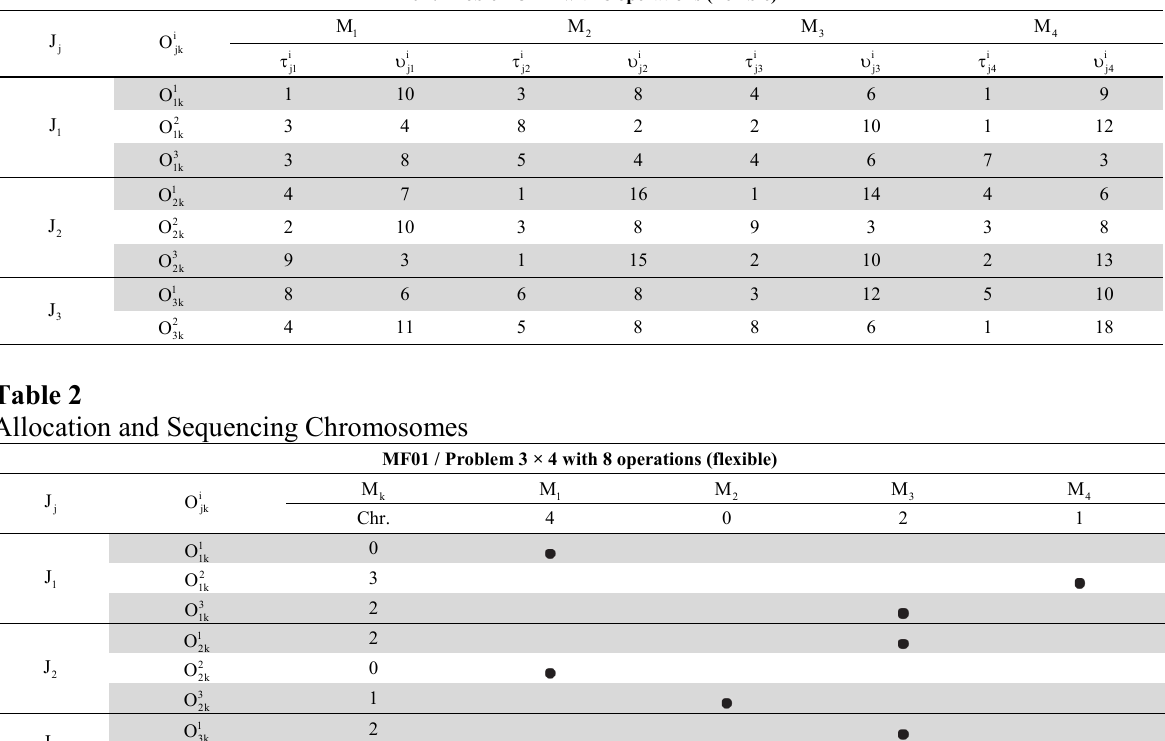
A Flexible Job-Shop Scheduling Problem MF01 / Problem 3 × 4 with 8 operations (flexible)